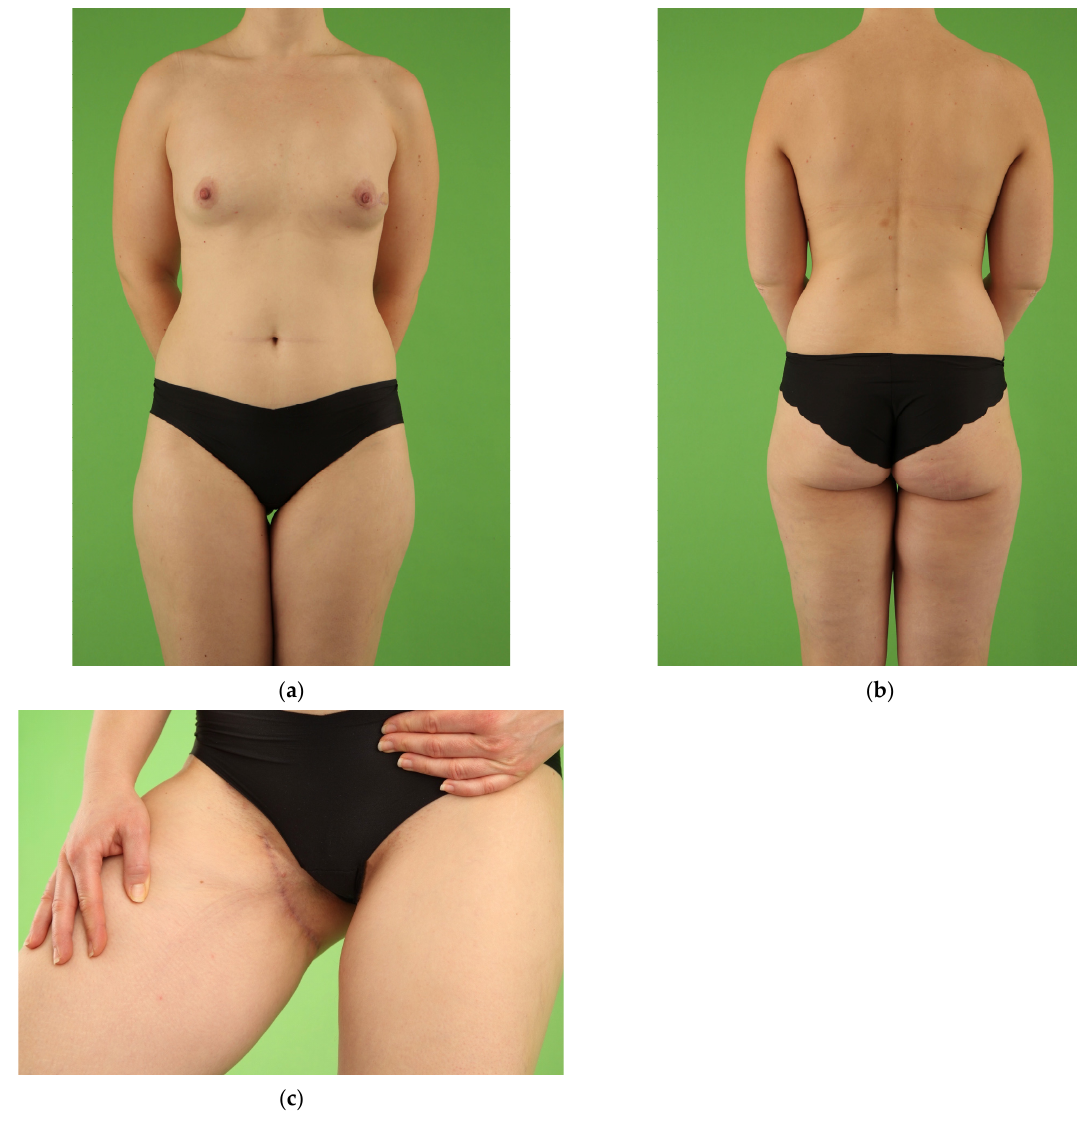
Figure 5. Normal weight female patient (39 years, BMI 22.9 kg/m 2 ) with positive BRCA mutation status. Nipple-sparing mastectomy of the left breast and immediate breast reconstruction with TMG flap from the right thigh. Nipple-sparing mastectomy of the right breast and immediate breast reconstruction with TMG flap from the left thigh is scheduled. Postoperative view at 0.5 year follow up. ( a ) Front view with appealing shape and symmetry of both small size breasts following TMG flap breast reconstruction of the left breast. TMG skin island visible on the outer left breast. Natural symmetry of the thighs after unilateral TMG flap harvest with secret scar in the groin of the right donor thigh; ( b ) Back view with secret scar in the natural crease of the right donor thigh; ( c ) Excellent shape of the right donor thigh with active scar in concealed position in the groin.